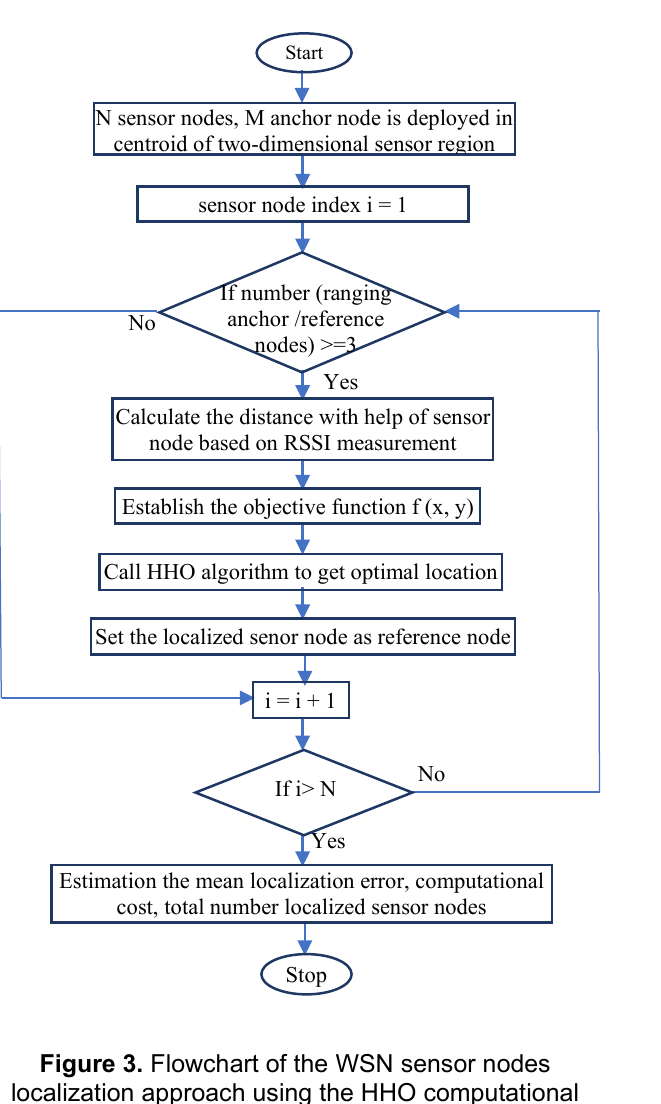
Figure 3. Flowchart of the WSN sensor nodes localization approach using the HHO computational intelligence